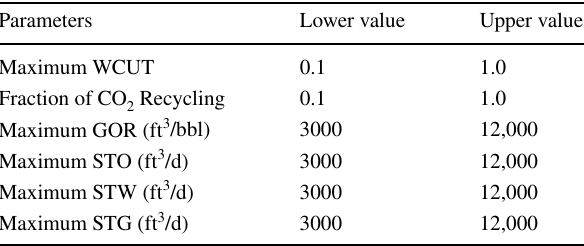
Table 4 Range of each parameter used in the optimization process Parameters